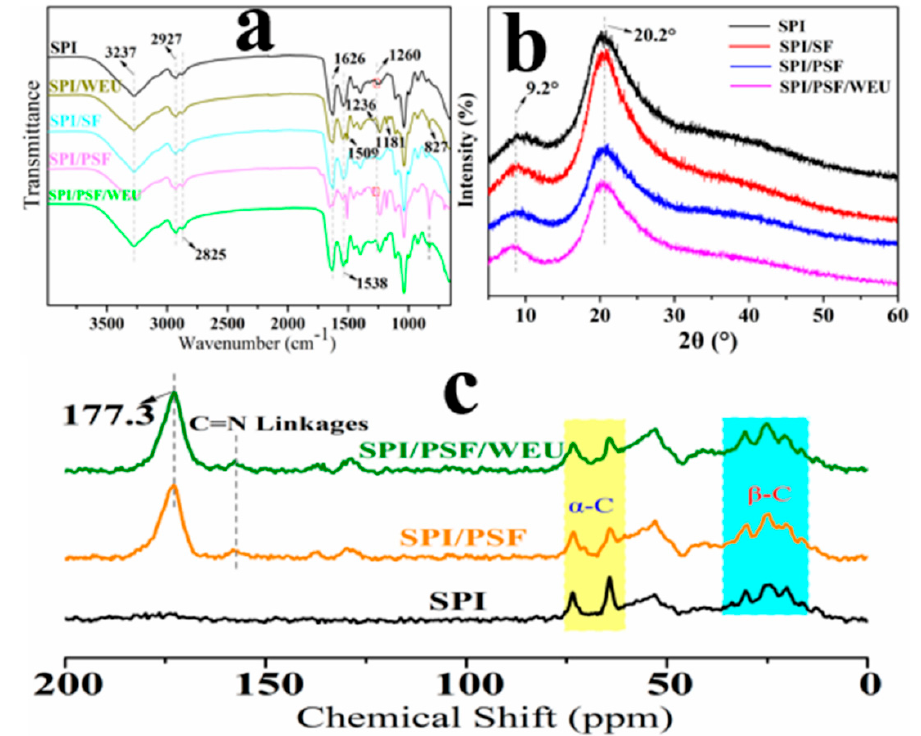
Figure 4. FTIR spectrum of neat SPI, SPI / WEU, SPI / SF, SPI / PSF and SPI / PSF / WEU films ( a ), XRD curves of neat SPI, SPI / SF, SPI / PSF, and SPI / PSF / WEU films ( b ), and solid-state 13 C NMR analysis of neat SPI, SPI / PSF, and SPI / PSF / WEU films ( c ).